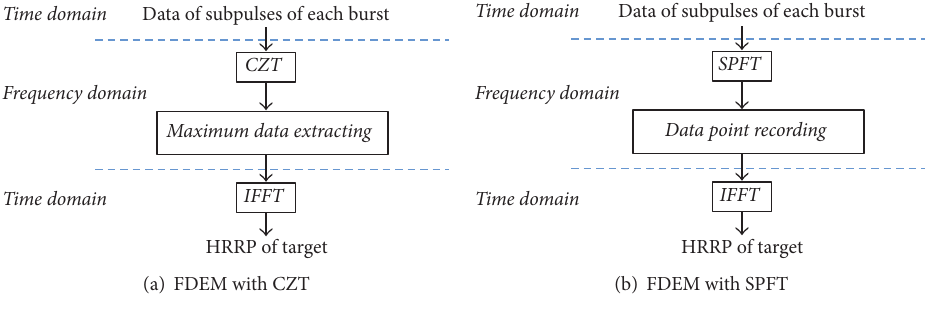
Figure 6: FDEM with CZT and SPFT.